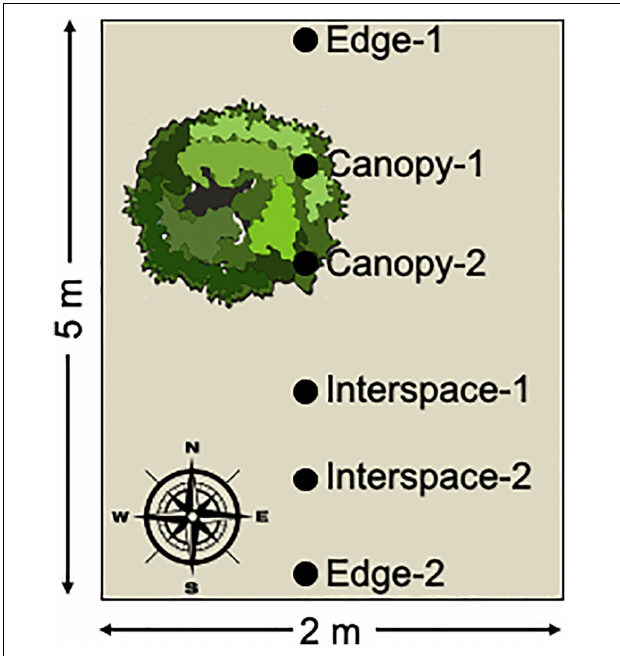
FIGURE 1 | Schematic diagram of sample collection. Surface soil samples were collected along a roughly north to south transect from each sampled plot. The transect encompassed three habitat patches: canopy zone soils in the dripline of the dominant shrubs, interspace soils in the unvegetated patches of the plot, and edge soils at the plot boundaries. Two replicate samples were collected for each habitat patch and four plots were sampled per treatment, for a total of 8 biological replicates per site, treatments, and habitat patch, resulting in a total of 192 soil samples